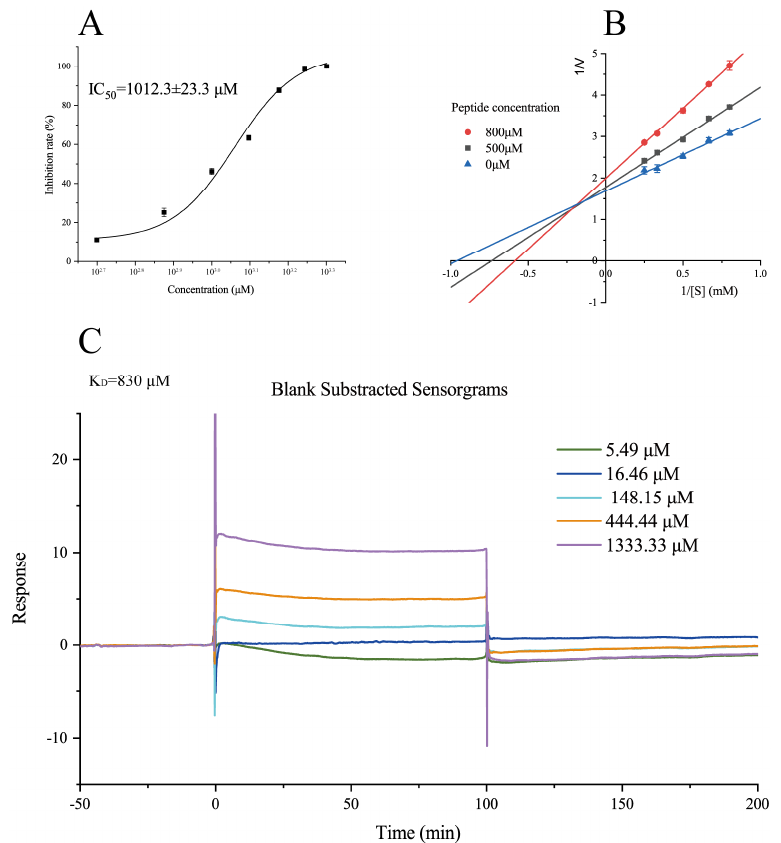
Figure 3. The DPP-IV inhibitory activity of GPXGPPGPG. ( A ) The IC 50 value. ( B ) Lineweaver-Burk double inverse plots. ( C ): SPR analysis of the interaction.